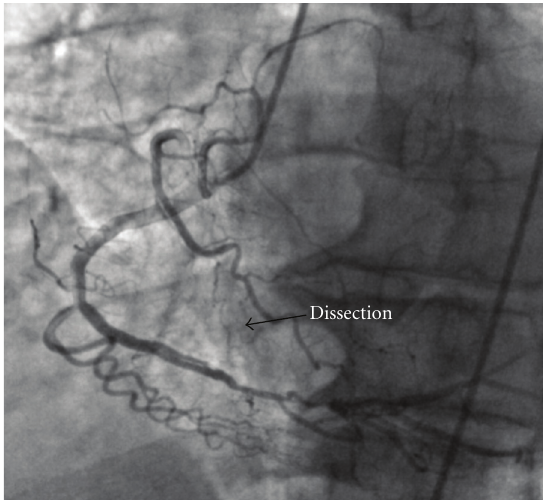
Figure 2: Nonocclusive right coronary artery